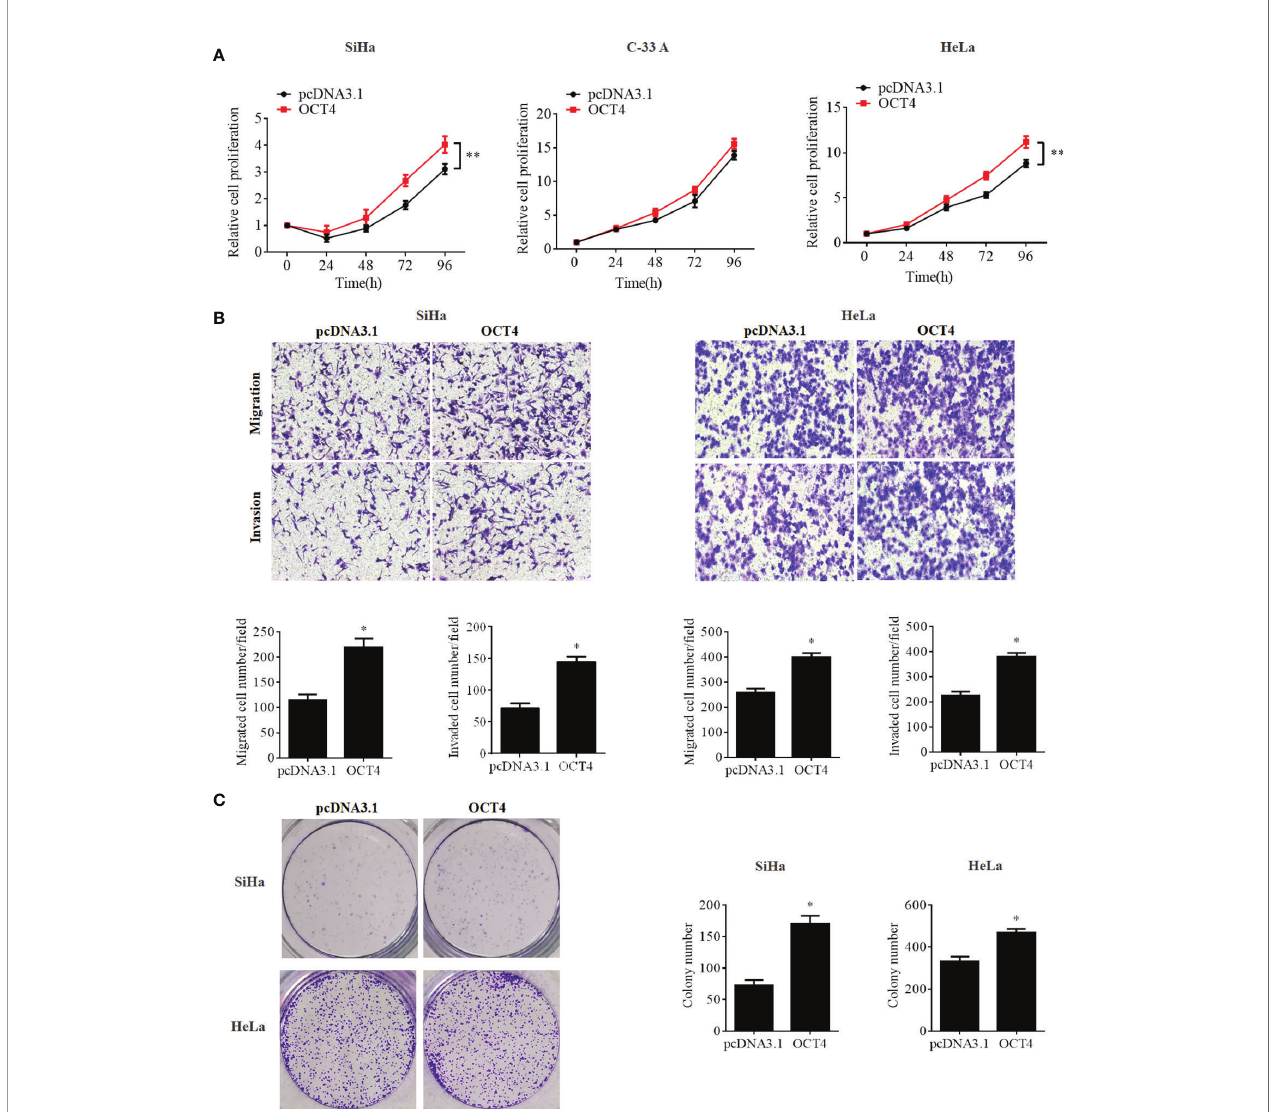
FIGURE 5 | OCT4 overexpression promoted cell proliferation, migration, invasion, and colony formation activities in human cervical cancer cells. (A) MTT assay analysis of proliferation abilities in the human cervical cancer cell lines SiHa, C-33A, and HeLa transfected with pcDNA3.1-OCT4 or pcDNA3.1. (B) Transwell assay analysis of migration and invasion abilities in the human cervical cancer cell lines SiHa and HeLa transfected with pcDNA3.1-OCT4 or pcDNA3.1. (C) Representative photographs of OCT4 overexpression on colony formation in SiHa and HeLa cells. * p < 0.05, ** p < 0.01 vs.